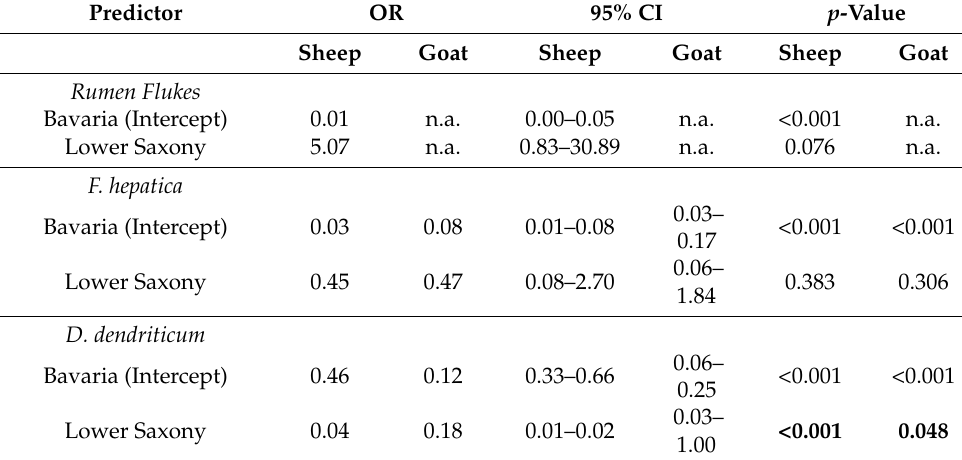
Figure 2. Prevalence of patent fasciolosis and dicrocoeliosis, including 95% CI for goat farms in Ba- varia and Lower Saxony. Note that no patent paramphistomidosis was diagnosed in the examined goat herds. Abbreviations: CI, confidence interval.